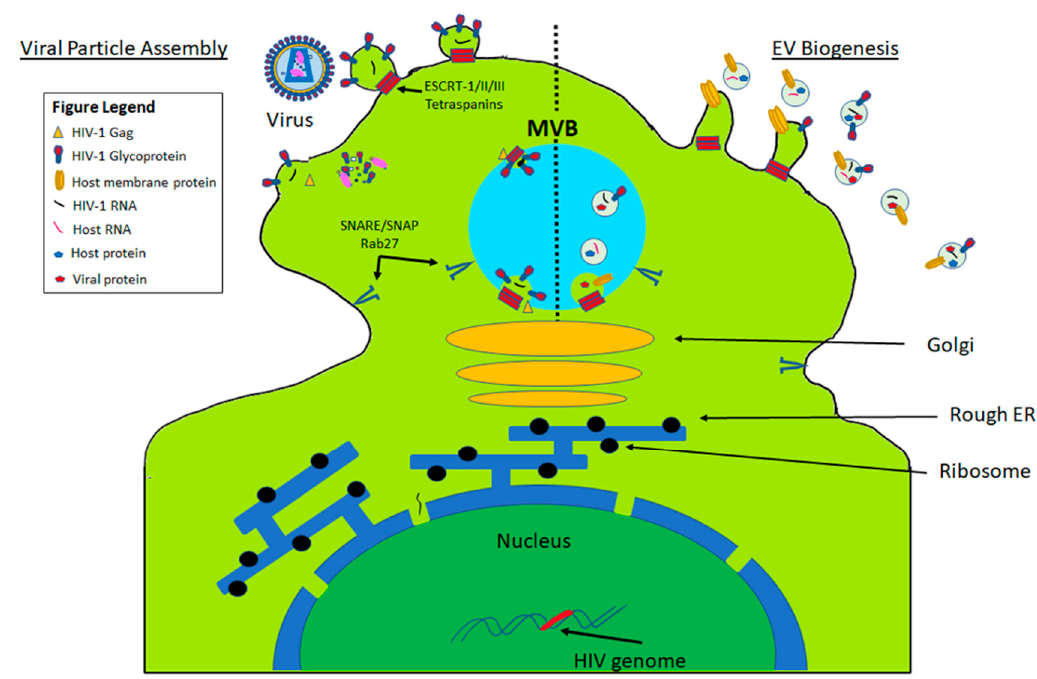
Figure 2. Comparison of viral and EV biogenesis. Infected cells concurrently release EVs and retroviral particles, possessing shared pathways at the MVB and the PM, whilst incorporating SNARE / SNAP Rab27 and tetraspanins, and ESCRT proteins in both pathways [1]. Depicted here is: sorting and transport of the exosome-specific proteins to the nascent ILVs, and excision from the MVB, Gag-mediated virion assembly at the PM or the MVB, and EV and virion release, [1,3].